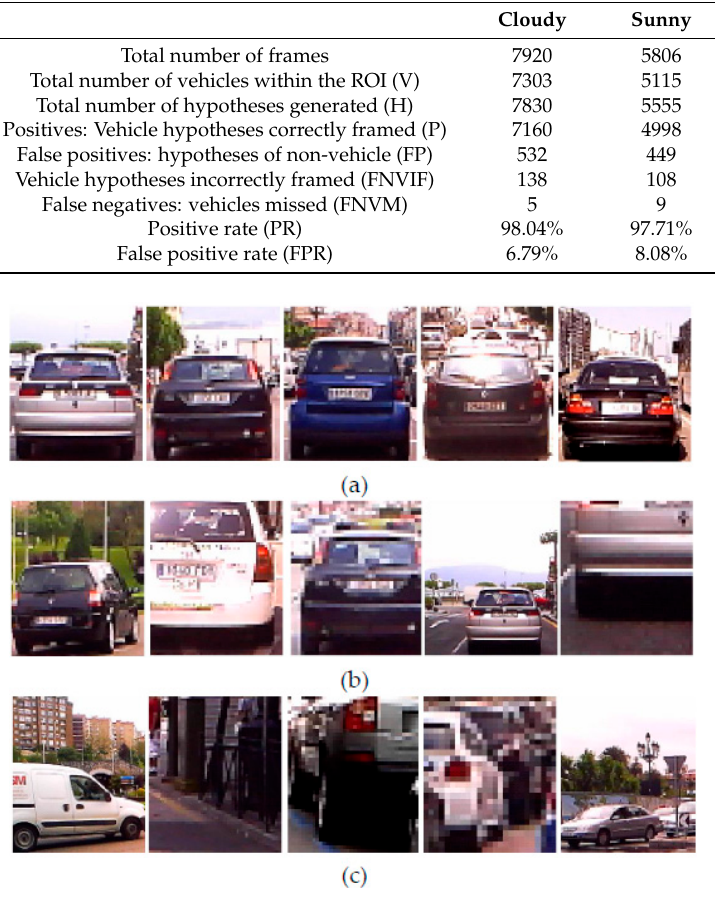
Figure 8. Example results: ( a ) positive hypotheses, ( b ) hypotheses corresponing to vehicles incorrectly framed; and ( c ) false positives corresponding to non-vehicles or vehicles out of system’s scope.